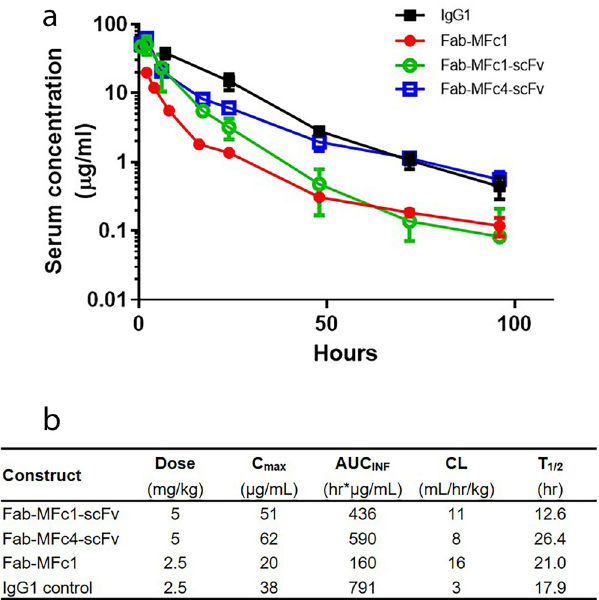
Fig. 6 In vivo mouse PK analysis of monomeric Fc – bispeci fi c antibodies. a hFcRn transgenic mouse serum clearance curves are plotted for Fab-MFc1- scFv, Fab-MFc4-scFv, Fab-MFc1, and IgG1 control ( n = 4 animals per time point), based on concurrent Fab and Fc domain binding. b PK parameters were determined by noncompartmental analysis with model 201. AUC INF = area under the concentration-time curve for the plasma concentration versus time graph from time 0 to in fi nity; CL clearance, C max peak concentration, t 1/2 = terminal